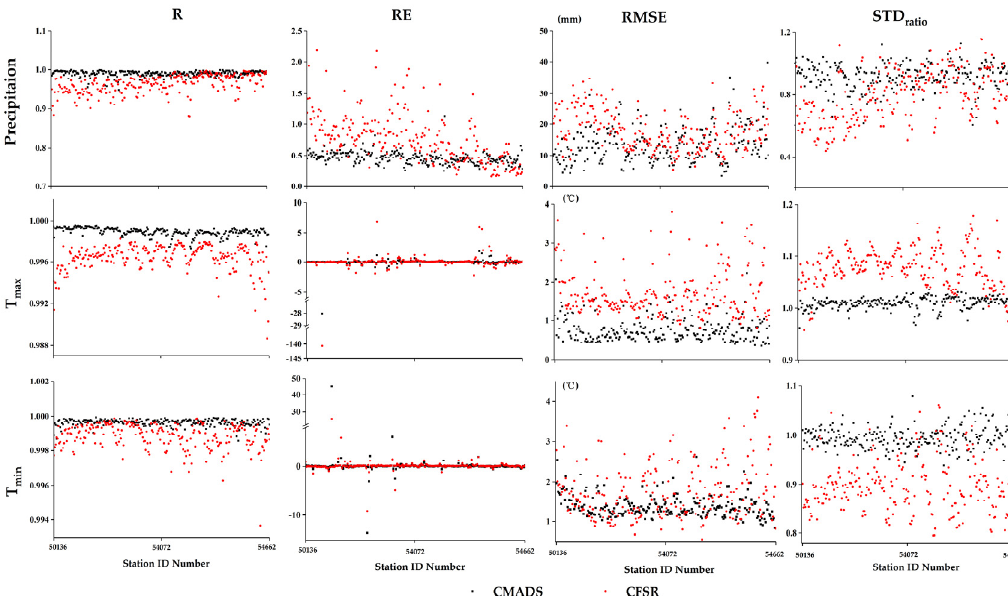
Figure 2. Statistical indicators for the comparison of CMADS and CFSR with observed data at 236 stations in Northeast China (NEC) at the monthly scale during the period 2008–2013. Marks: The figures in the first, second, and third lines show the four statistical indicators of the comparisons in precipitation, maximum temperature, and minimum temperature, respectively. Table 5. Average statistical indicator values for comparing CMADS and CFSR with observed data.